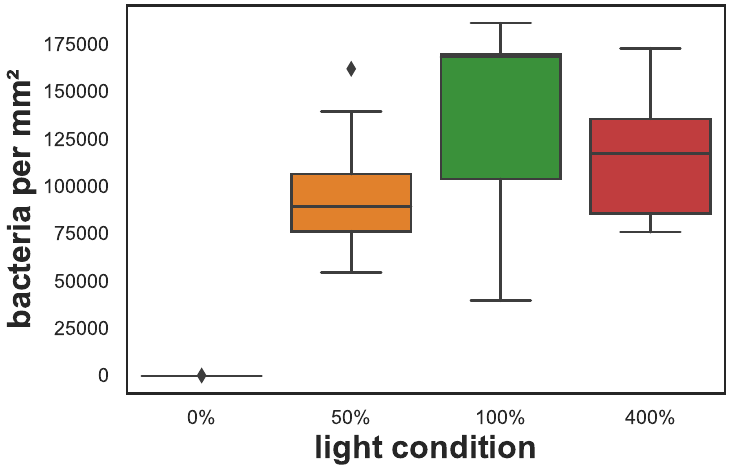
Figure 4. Cyanobacteria density in cryosections of the sponges after 67 days of exposure to different light conditions. The box shows the quartiles of the data-set while the whiskers show the rest of the distribution, except for outliers that are plotted as